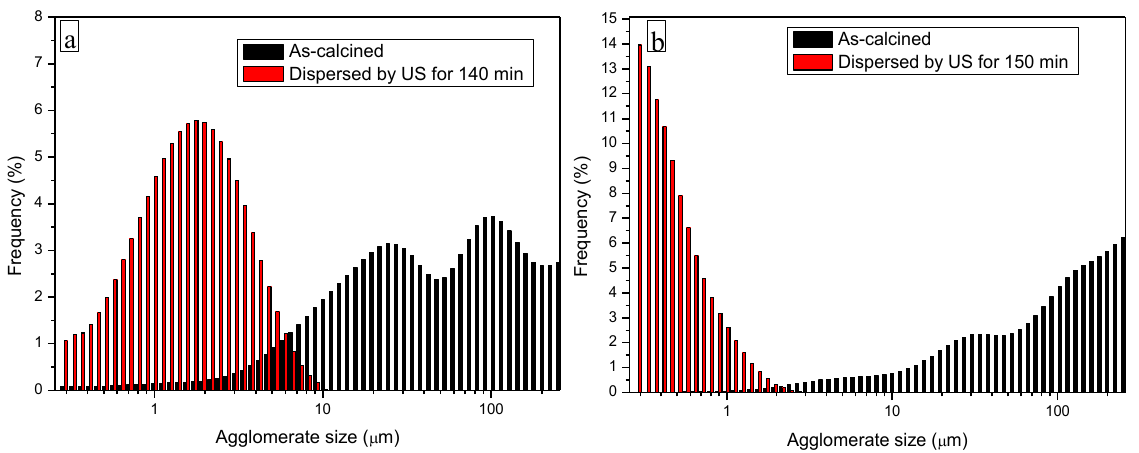
Figure 4. Frequency distribution (vol%) vs. agglomerate size of ( a ) YAG cl -AA and